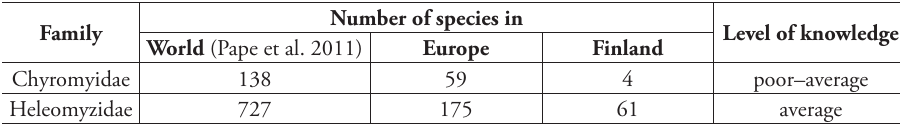
Level of knowledge